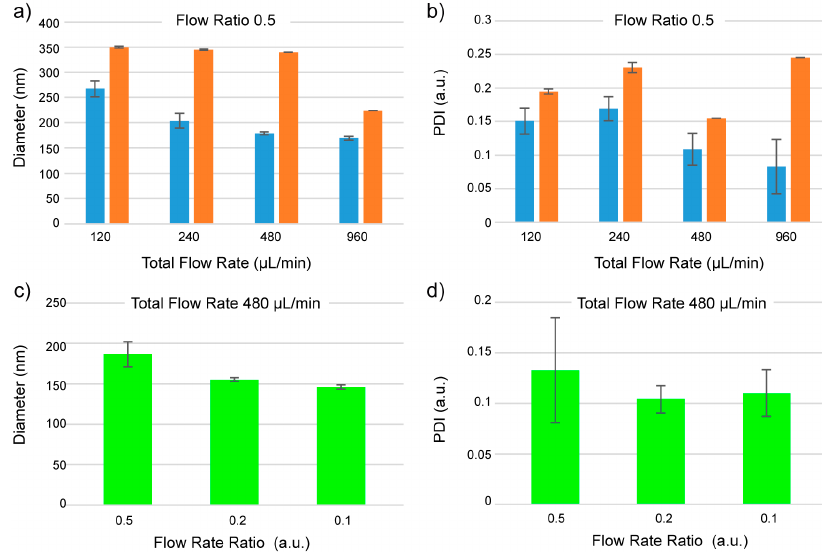
Figure 3. Characterization of the precipitated PNPs. ( a ) Sizes of the PNPs generated at a flow ratio of 0.5 with (blue) and without (orange) cavitation-assisted nanoprecipitation. The particle size decreases for increasing total flow rates. ( b ) Polydispersity of the same particles of ( a ). ( c , d ) Effects on PNPs both size and distribution of the ratio between the flow rates of the solvent and non-solvent solutions. A reduction of the sizes with decreasing values of the flow rate ratio is